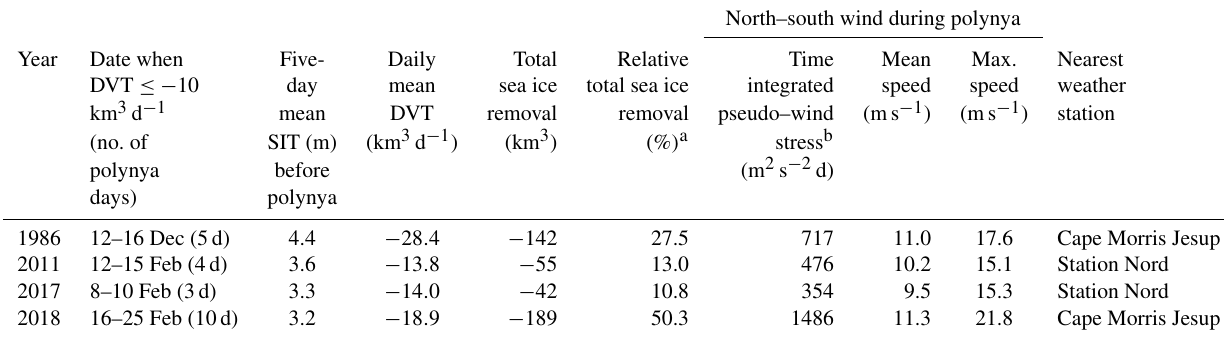
Table 1. Characteristics of the polynya events, when daily dynamic sea ice removal is greater than 10km 3 d − 1 (i.e., dynamic volume tendency (DVT) ≤ − 10km 3 d − 1 ) for more than 3 consecutive days and the corresponding wind condition near a weather station as well as sea ice thickness (SIT) over northern Greenland from the RASM hindcast simulation (1980–2020).